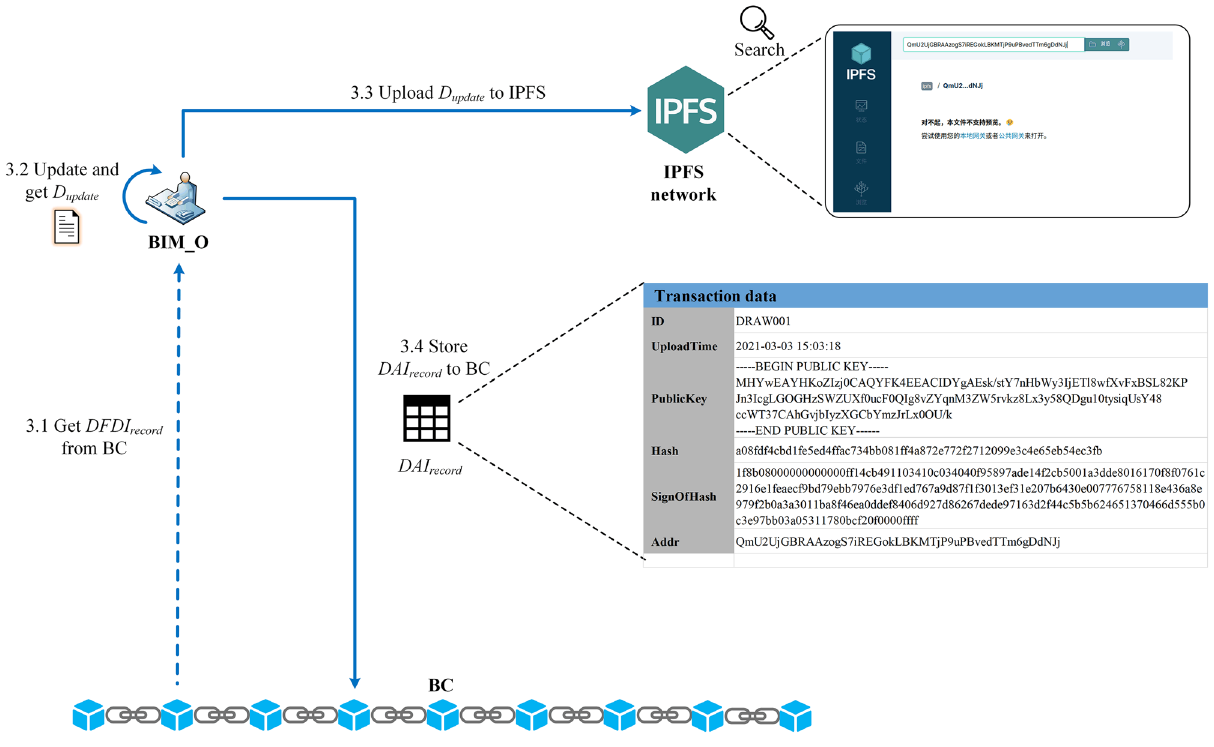
Figure 20. Example: BIM_O update BIM